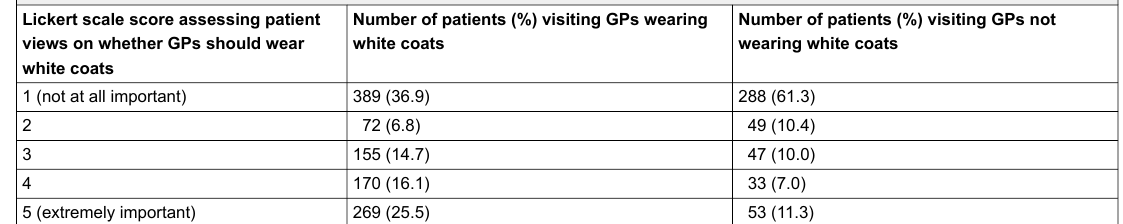
Table 2: Patient views on whether GPs should wear white coats according to whether GPs wear white coats or not (n = 1,525). Lickert scale score assessing patient views on whether GPs should wear white